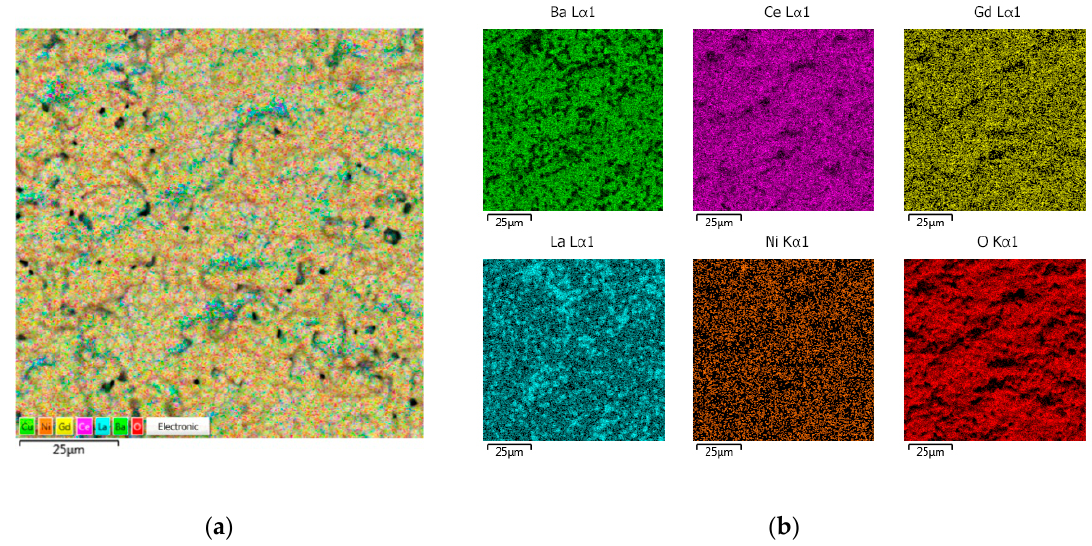
Figure 6. EDX mapping image the BCGCuO film deposited onto the LBNO substrate after the final sintering at 1450 ° С , 2 h: ( a ) total; ( b ) individual elements. Table 2. The averaged elemental composition of the BCGCuO film on the modified cathode LBNO after final sintering at 1450 ° С .